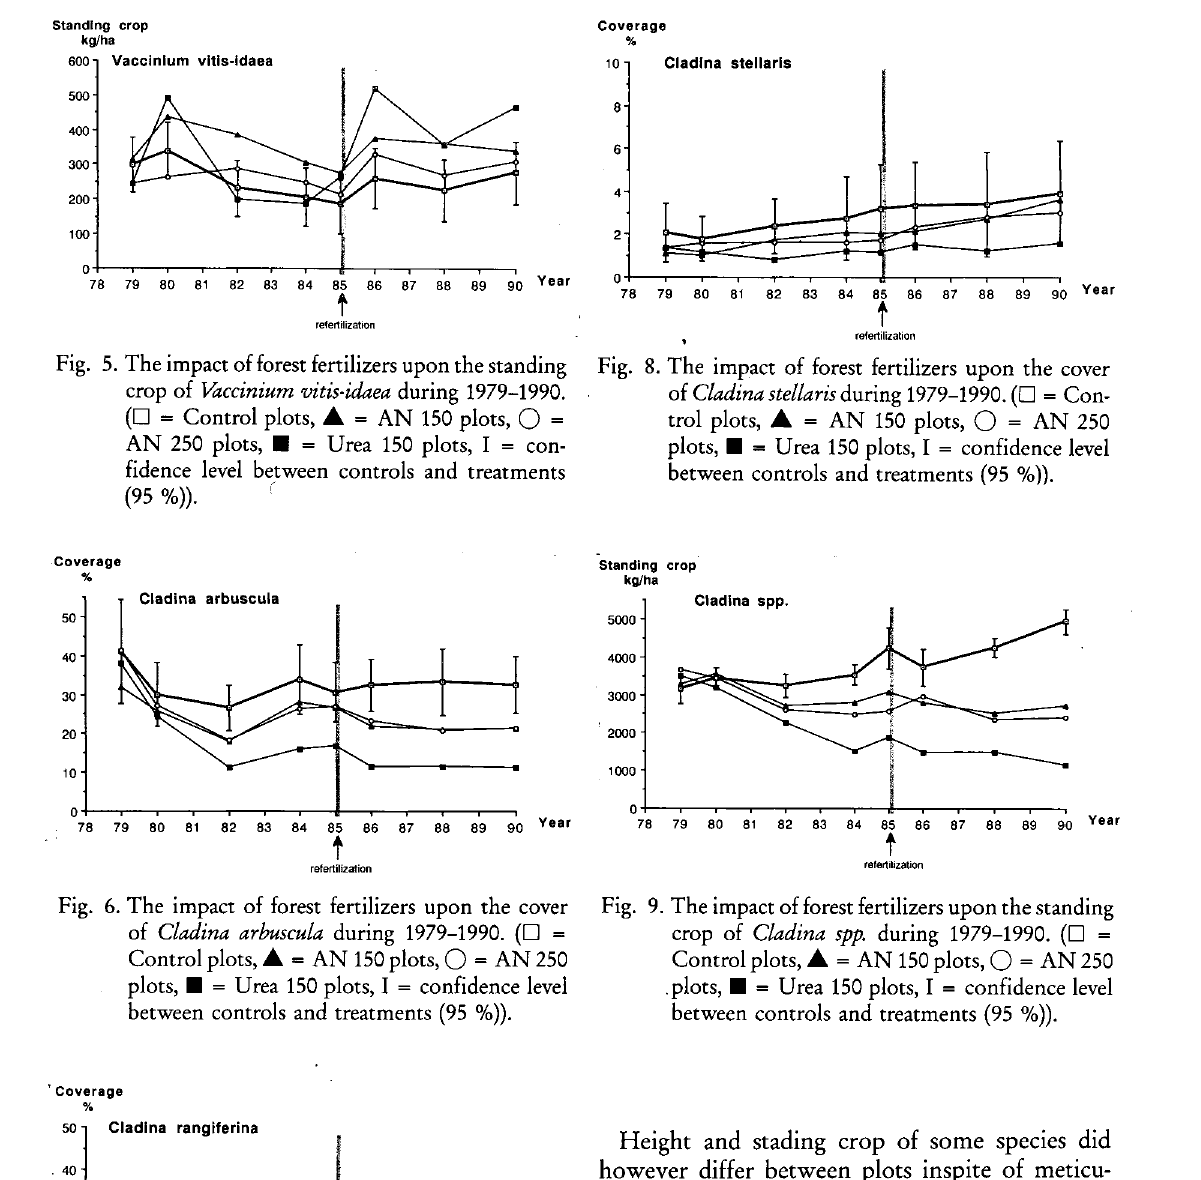
Fig. 9. The impact of forest fertilizers upon the standing crop of Cladina spp. during 1979-1990. (• = Control plots, A = AN 150 plots, O = AN 250 plots, • = Urea 150 plots, I = confidence level between controls and treatments (95 %)).